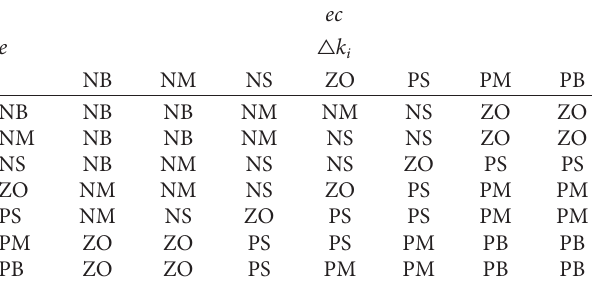
of fuzzy control i